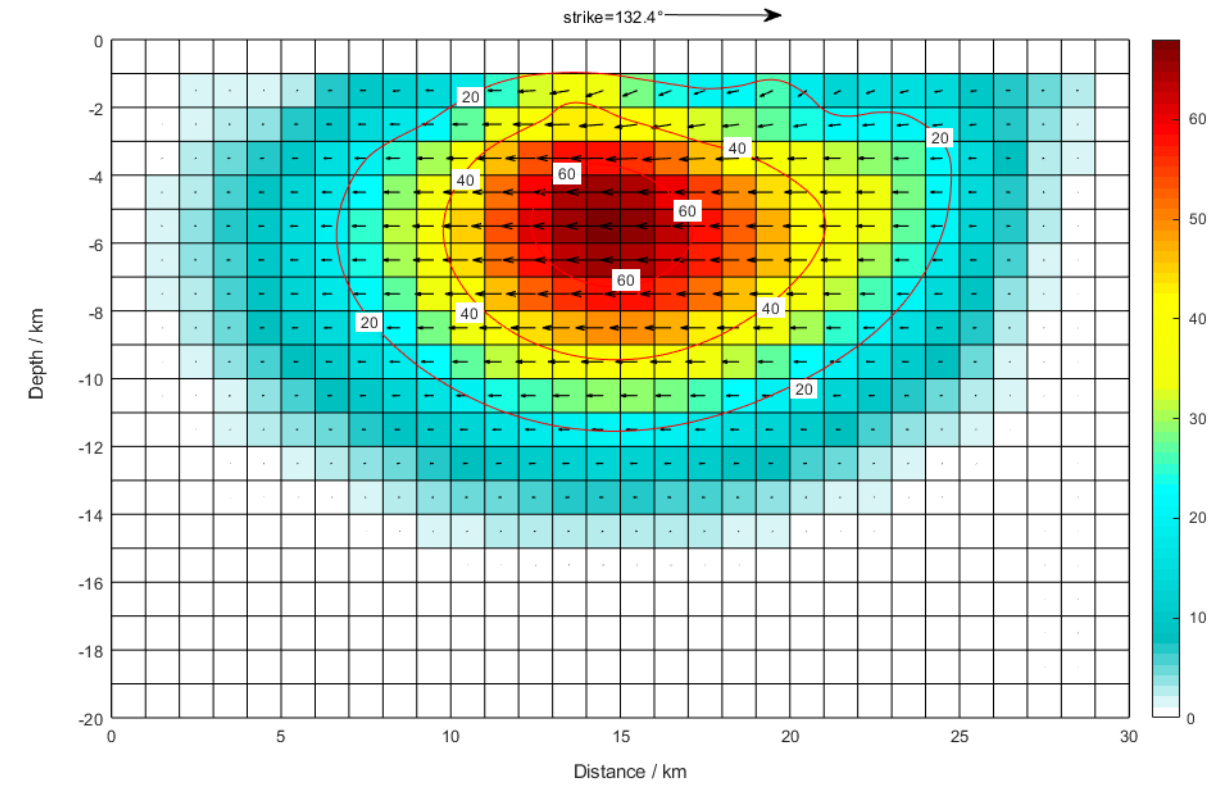
Figure 4. Fault slip distribution 2D display.